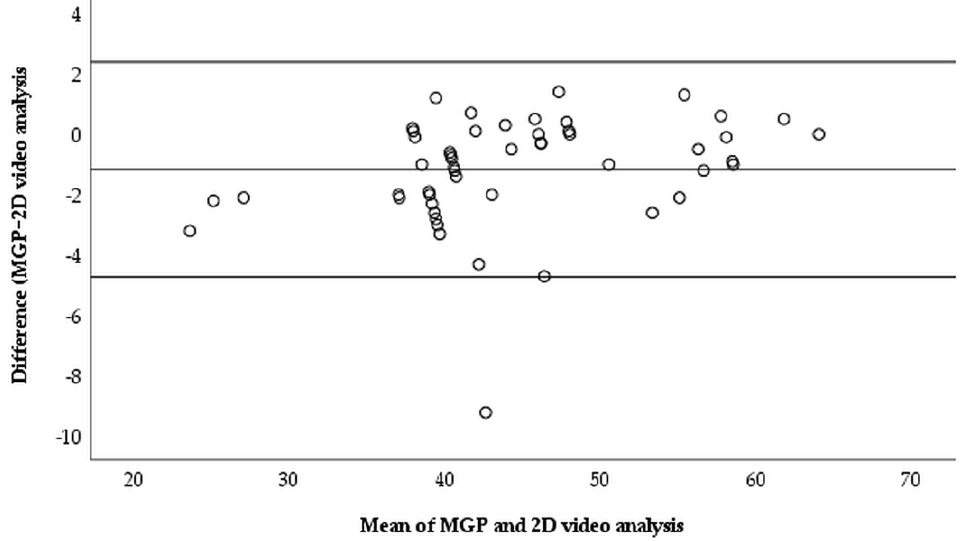
Figure 4. The modified goniometric platform and video analysis measurement for left trunk rota- tion.